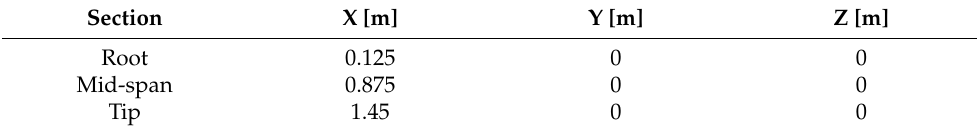
Table 2. Spar’s interest points location.